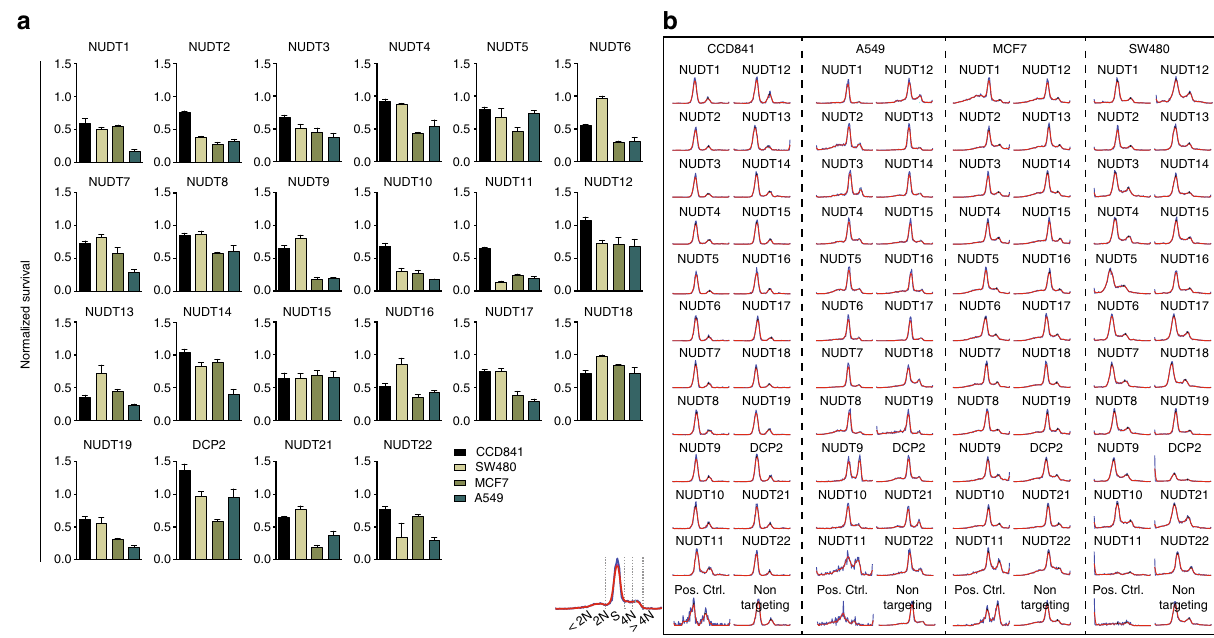
Fig. 4 Cell viability and cell cycle pro fi les upon single NUDIX depletion. a Survival of CCD841, A549, MCF7, and SW480 cells upon single depletion of the NUDIX enzymes using a pool of four siRNA sequences. The survival was measured by resazurin and normalised to the non-targeting siRNA control. b Cell cycle pro fi les upon single NUDIX knockdown in CCD841, A549, MCF7, and SW480 cells. The histograms were obtained by measuring the integrated intensity of the DNA counterstained with Hoechst and the signal was then processed using PopulationPro fi ler as described in